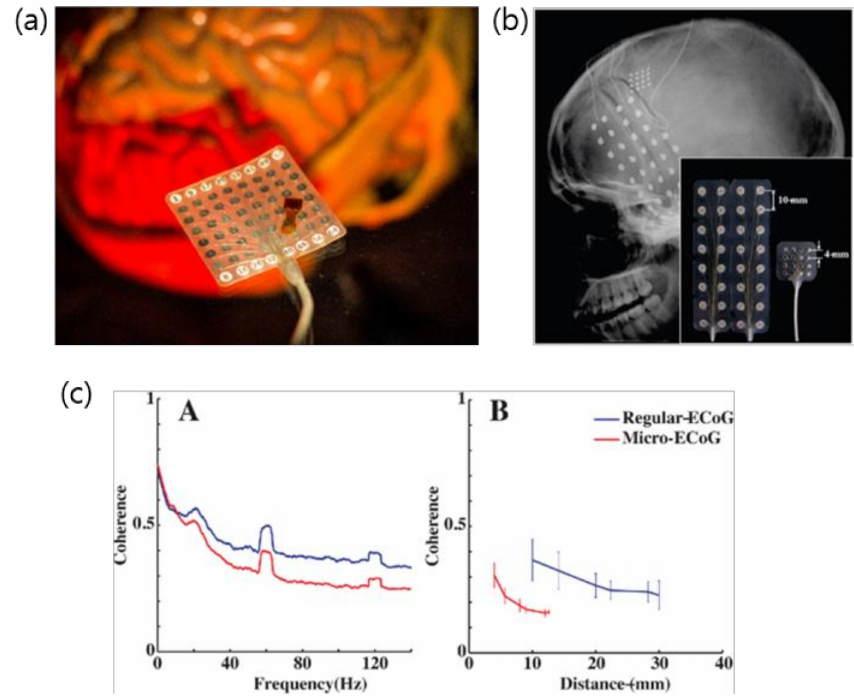
Figure 1. ( a ) Picture of a clinical electrocorticography (ECoG) grid underneath a micro-ECoG ( µ ECoG) array. Side-by-side comparison of the regular macro-ECoG and µ ECoG arrays showing difference in electrode spacing. ( b ) X-ray image showing the implanted ECoG and µ ECoG electrode. ( c ) Coherence analysis to characterize independent neural signals recorded from both macro-ECoG and µ ECoG. This suggests µ ECoG offers higher spatial resolution for neural signal recording. ( a ) Photo was taken at Neural Interfaces Research (NITRO) lab at University of Wisconsin (UW) Madison; ( b , c ) reprinted with permission from Reference